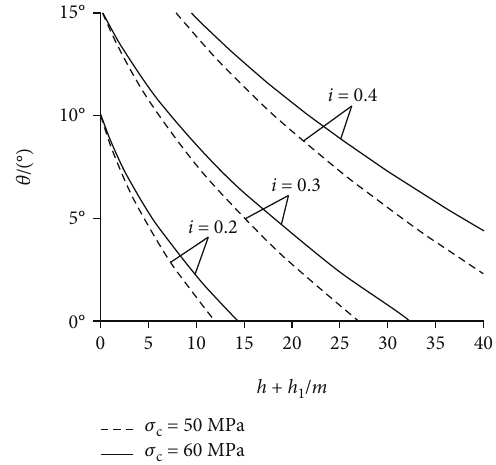
Figure 6: Relationship between angle of rotation θ and the bearing ) of the thickness ( h + h 1